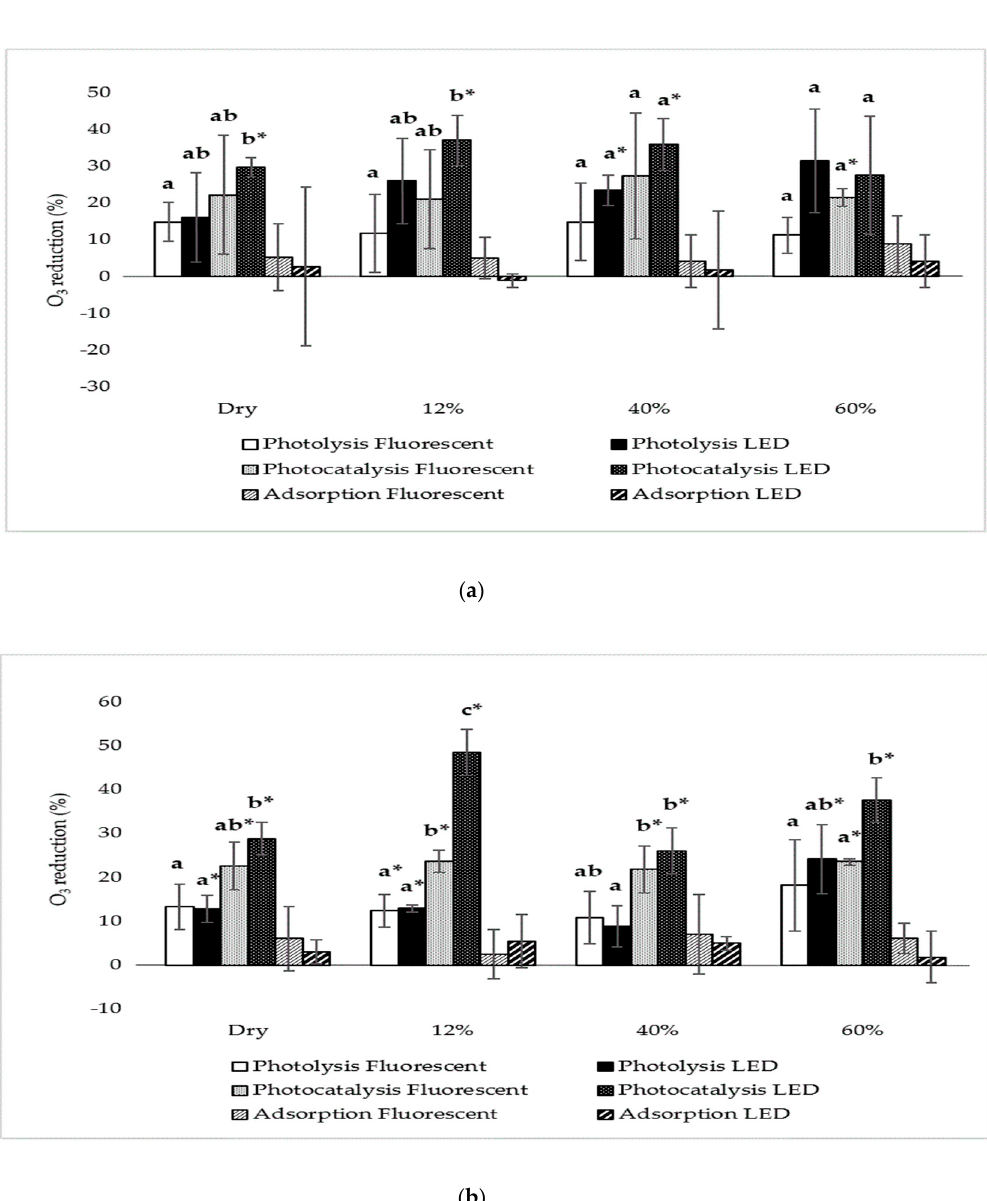
Figure 15. Comparison of O 3 mitigation under di ff erent treatment types and light intensity. ( a ) % reduction at treatment time of 40 s; ( b ) % reduction at treatment time of 200 s; Superscript (*) signifies a statistical di ff erence compared to the control ( p < 0.05), and the di ff erent characters (a, b) signify a statistical di ff erence when comparing di ff erent light intensities (fluorescent vs. LED) at the same relative humidity ( p < 0.05). Error bars signify ± standard deviation.